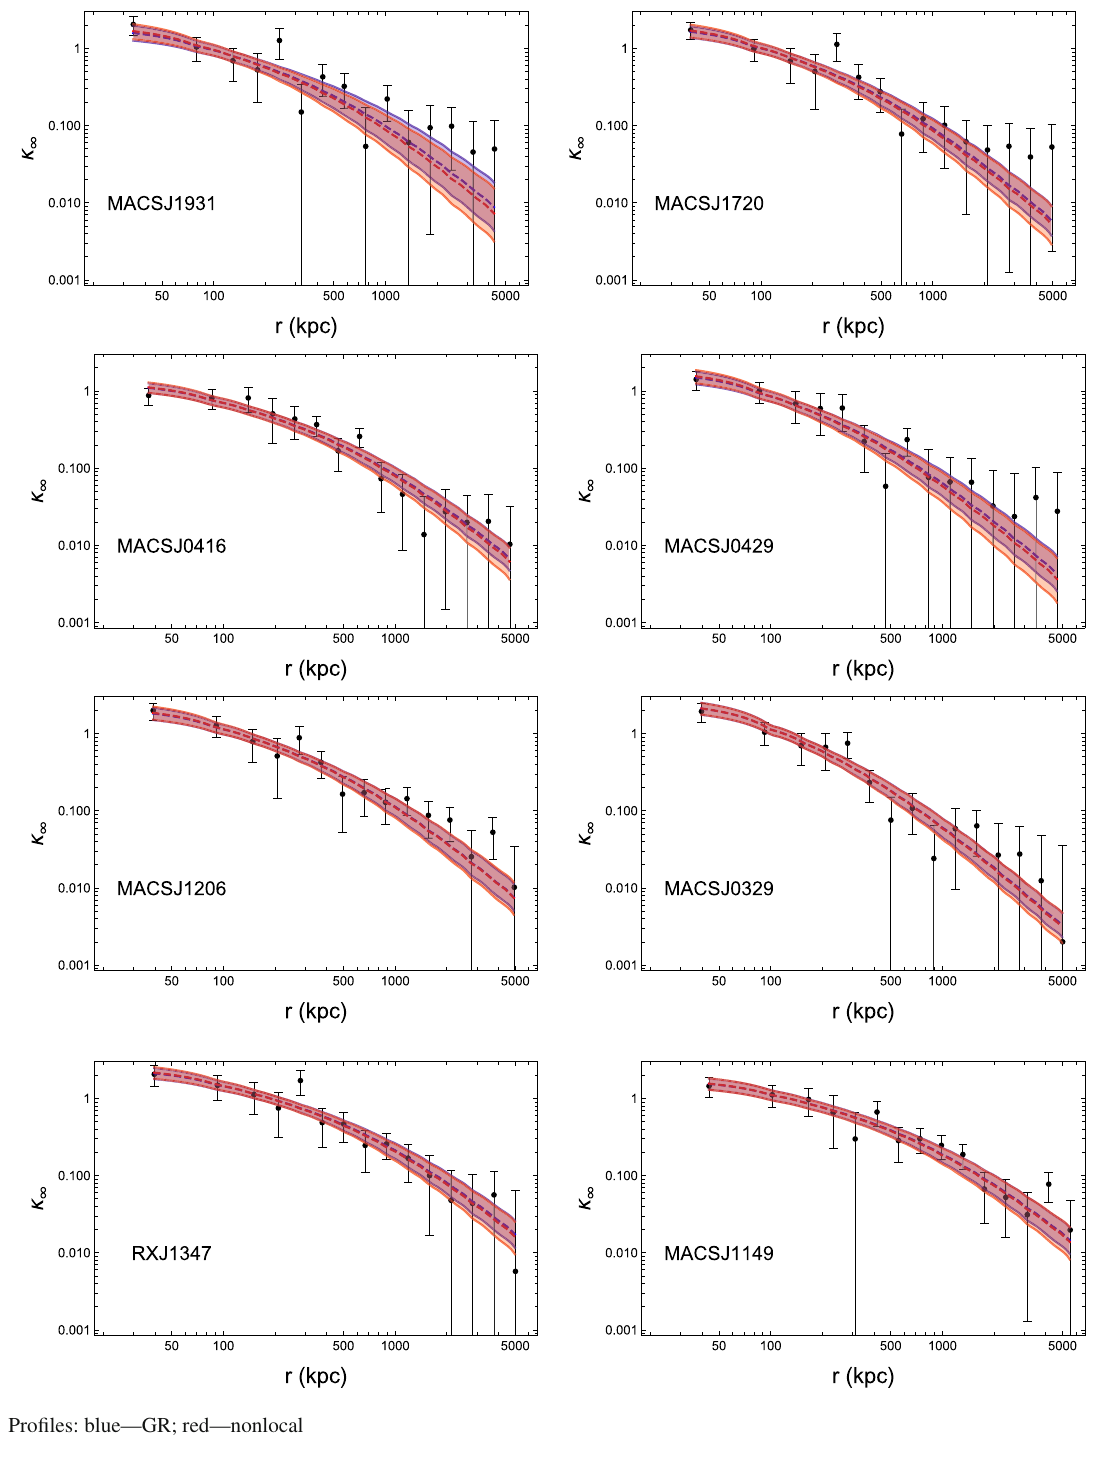
Fig. 9 Profiles: blue—GR;